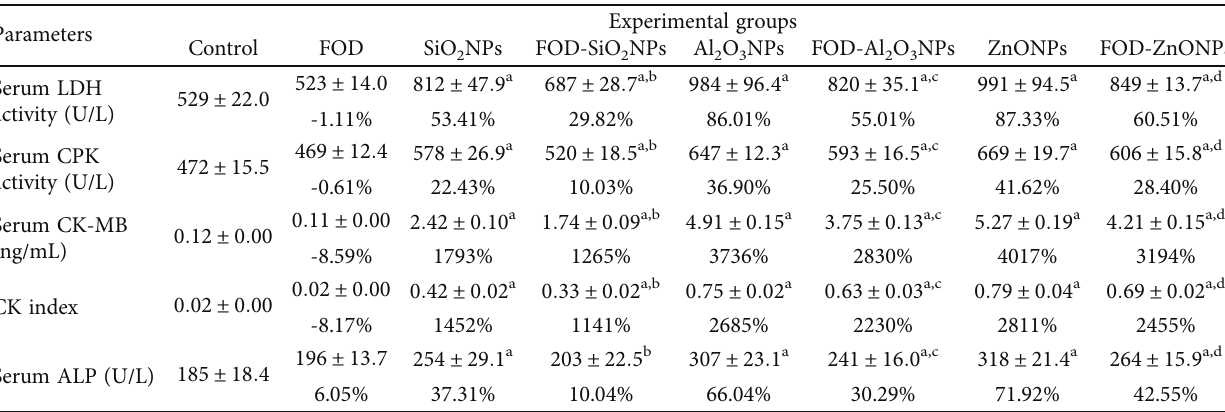
Table 3: The e ff ects of fi g with olive oil and date palm fruit extract on the myocardial enzymes and ALP of male rats treated with silicon oxide nanoparticles, aluminum oxide nanoparticles or zinc oxide nanoparticles for 75 days.